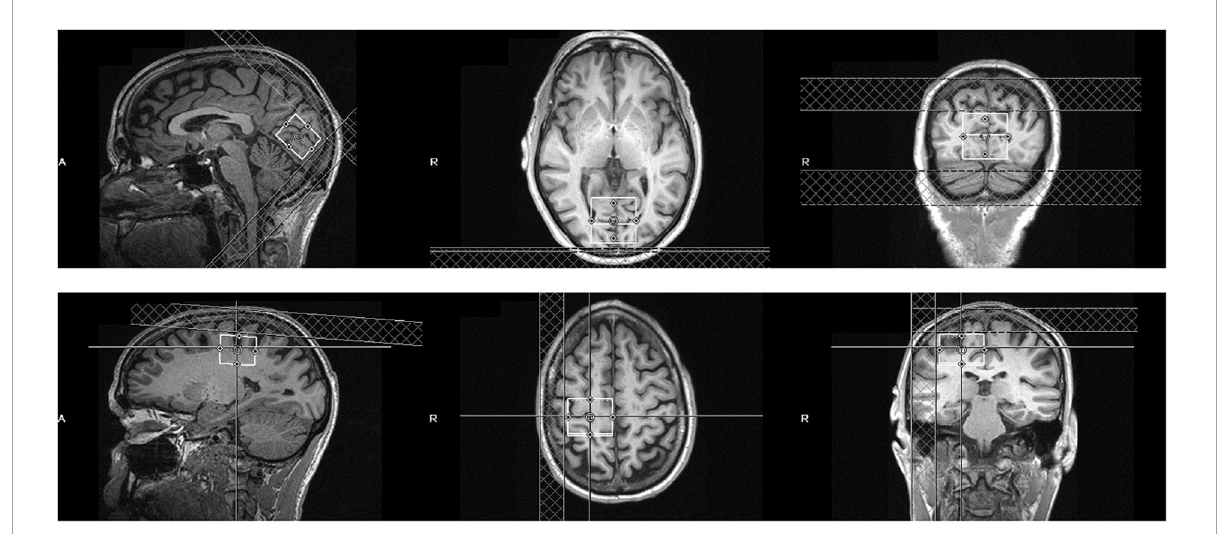
FIGURE1 Position of the visual cortical MRS voxel (top row) and sensorimotor control voxel (bottom row) in an example subject. The voxel is 3 × 3 × 3 cm and centered bilaterally over the calcarine sulcus (visual cortex) or right precentral gyrus (sensorimotor